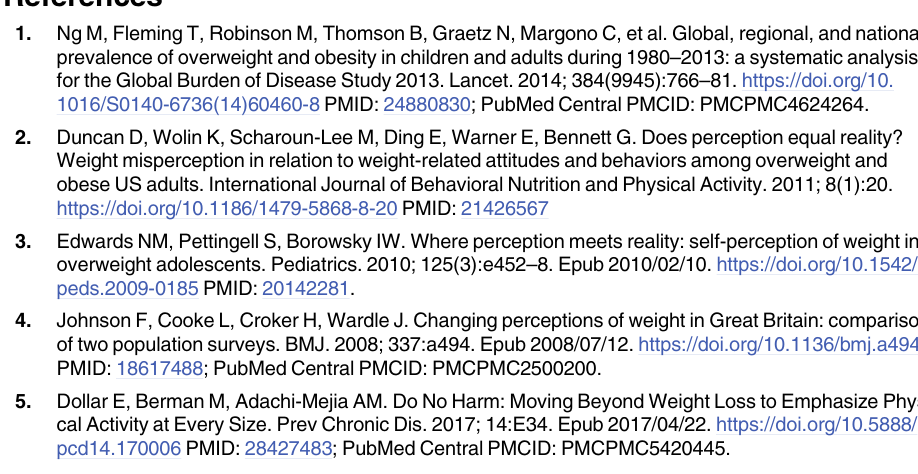
(Table F); Associations of weight status perception pattern and disordered weight control behaviors with depression among Korean women (Table G) and men (Table